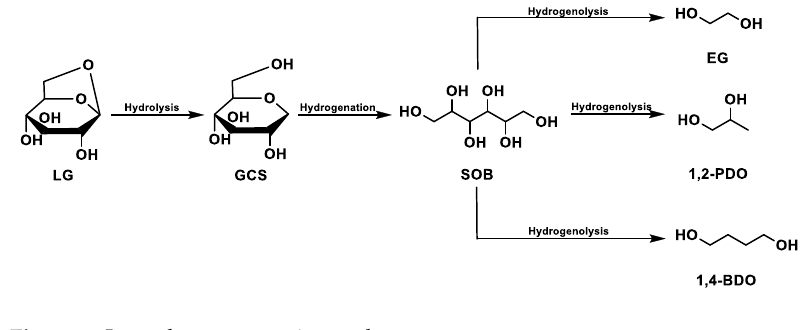
Figure 6. Levoglucosan reaction path.